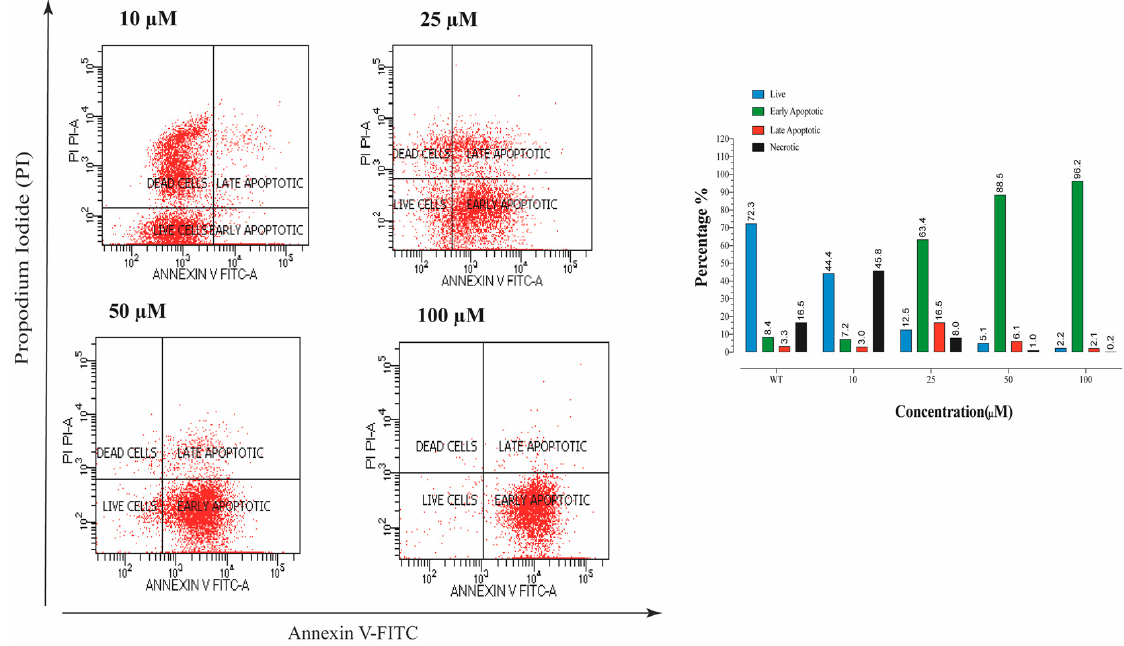
Figure 3. The apoptosis ratio of HeLa cells and contour diagram of Annexin-V/PI staining. A 25 µM effective dose of compound E dramatically increased the early apoptotic cell rate up to 63.4% compared to the record in control, 8.4%.